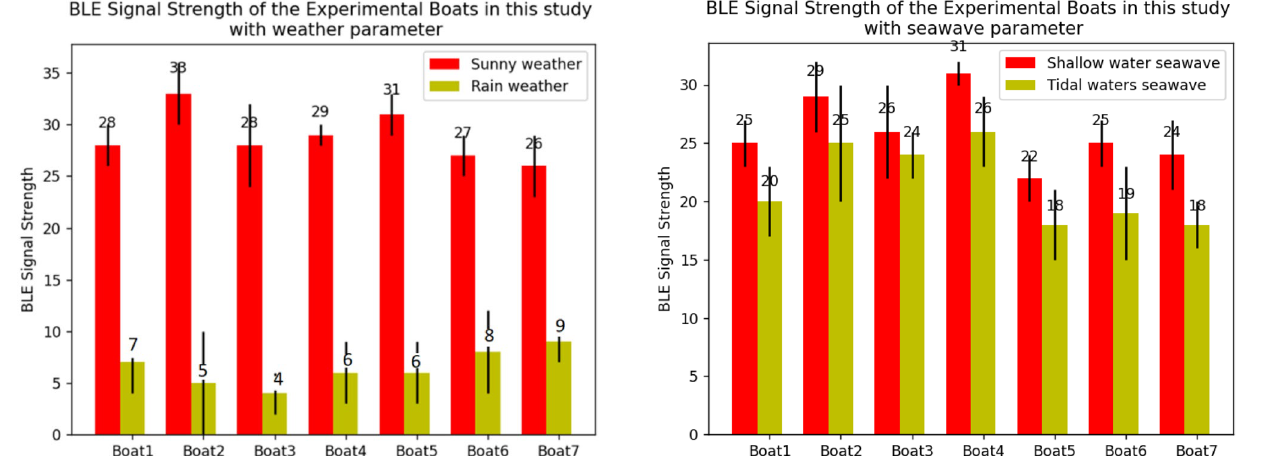
Fig. 10 Experimental result of BLE signal strength with weather parameter a red line indicated BLE signal strength in sunny weather; b brown line indicated BLE signal strength in rain weather